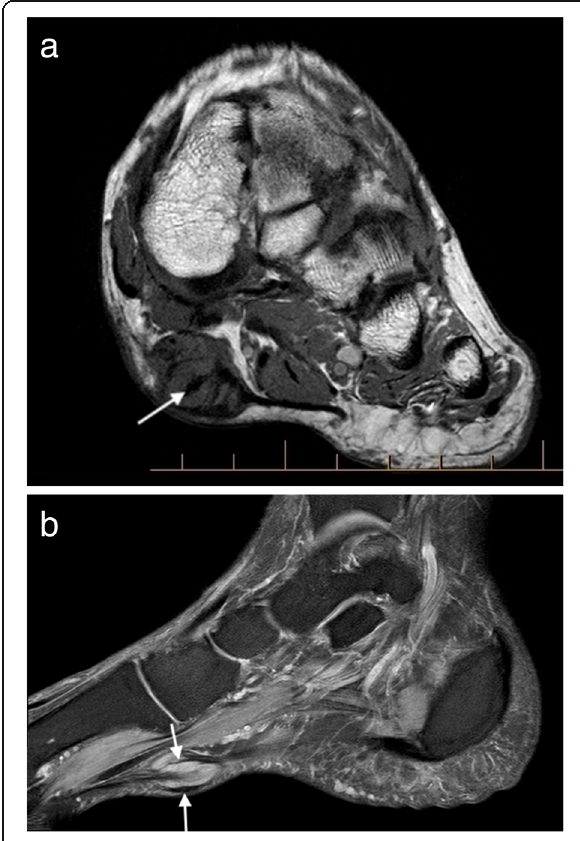
Fig. 1 Plantar fibroma. a Sagittal T2 fat suppressed (T2FS) and ( b ) coronal T1-weighted image of the foot demonstrating a heterogeneous mass centred on the plantar fascia, distinct from the underlying musculature. The characteristic low signal linear bands are shown